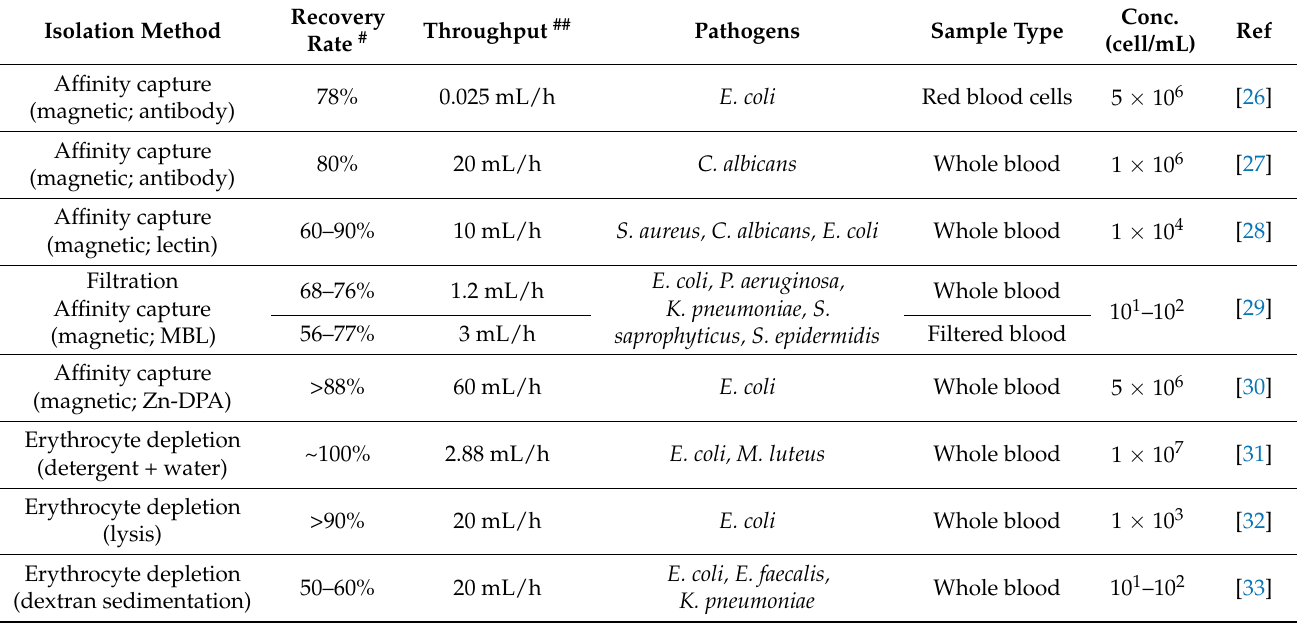
Table 2. Comparison of microfluidic techniques for isolating bloodborne pathogens. Values are estimated for a single channel with a single